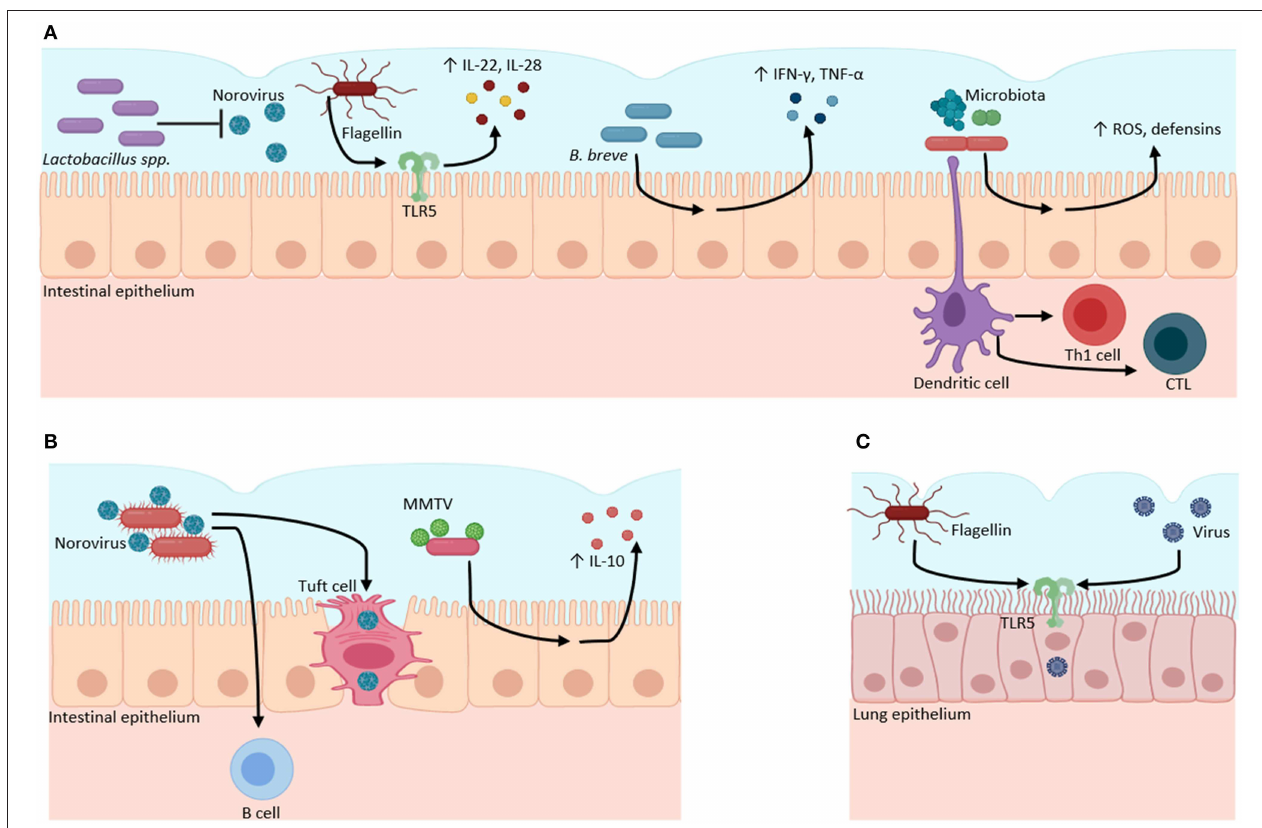
FIGURE 1 | Microbiota–virome interactions in mucosal surfaces. The microbiota has a dual role when it interacts with viruses. (A) Microbiota can have a protective role against viral infections. Bacteria from the Lactobacillus genus inhibit Norovirus infection. Bacterial flagellin activates TLR5 to produce inflammatory cytokines (IL-22, IL-18). B. breve stimulates the production of pro-inflammatory cytokines (IFN- γ , IL-4, TNF α ) against viruses. The gut microbiota regulates the production of ROS and defensins, and the activation of Th1 and CTL against viral infections. (B) Microbiota can function as an evasion mechanism, where viruses can bind to bacterial structural molecules (such as LPS) or bacterial pili or membranes to induce immunotolerance through the increase of anti-inflammatory cytokines (IL-10) and to infect host cells. (C) Bacterial flagellin increases the infectivity of influenza, Measles, Ebola, Lassa, and Vesicular stomatitis viruses through TLR5 activation in lung epithelial cell culture. Created with